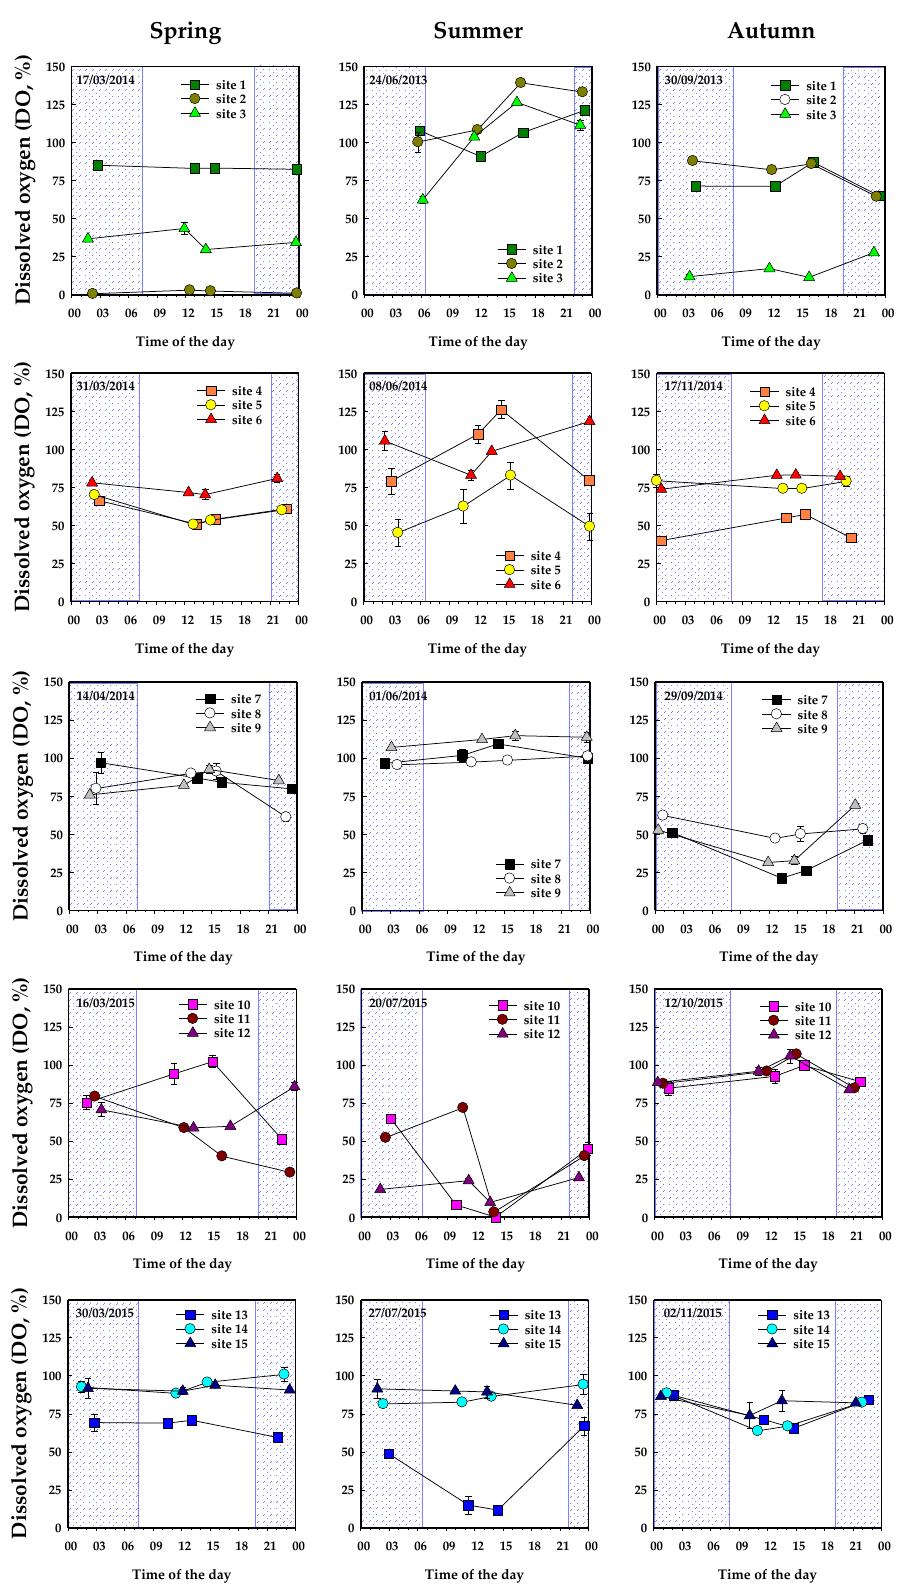
Figure 2. DO results from seasonal 24 h-cycle campaigns in LAC Lake. Measurements were carried out within densely vegetated areas, presenting biomass >100 g DW m −2 during samplings. Hatched color indicates night periods.